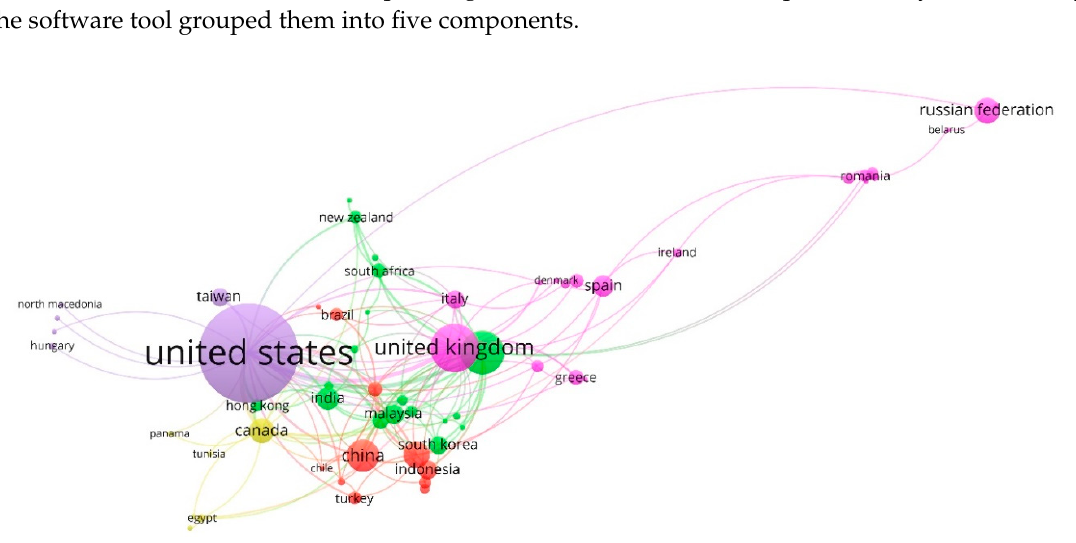
Figure 4. Network of countries based on the co-authorship method (1961–2019).